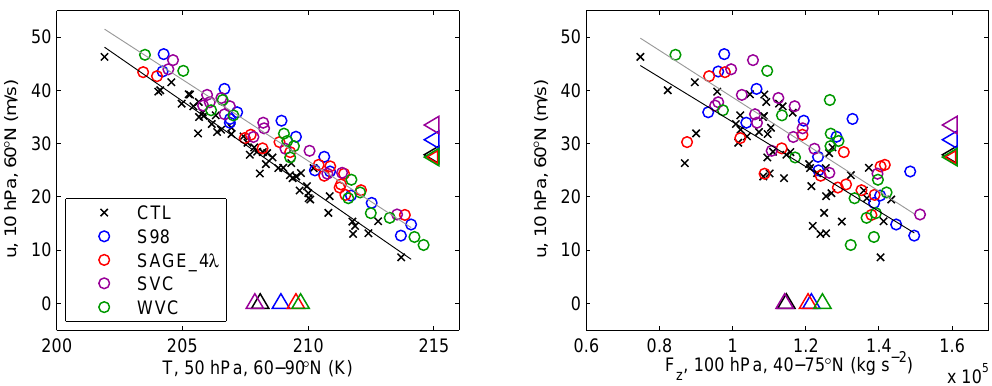
Figure 13. Scatter plots of vortex wind, temperature and wave forcing for the CTL and four volcanically forced ensembles. All quantities are averaged over the NH winter (DJF). Shown are (left) zonal wind at 10hPa, 60 ◦ N plotted against temperature at 50hPa, 60–90 ◦ N averaged, and (right) zonal wind at 10hPa, 60 ◦ N plotted against the vertical component of EP-flux averaged over 40–75 ◦ N. Individual forced ensemble members are shown by coloured circles, and the CTL ensemble members by black crosses. Ensemble mean values of the quantities plotted on the horizontal and vertical axes of each panel are shown by coloured (black) triangles for the forced (CTL) ensembles along the bottom and right-hand